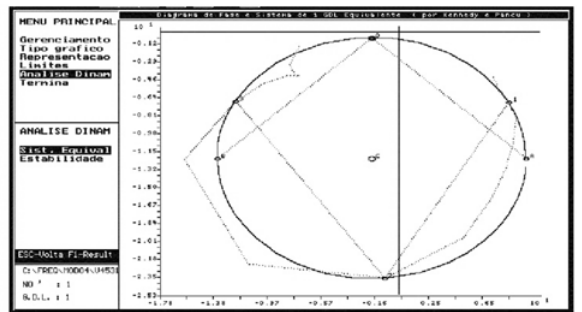
Figure 4. Program FREQ user interface.